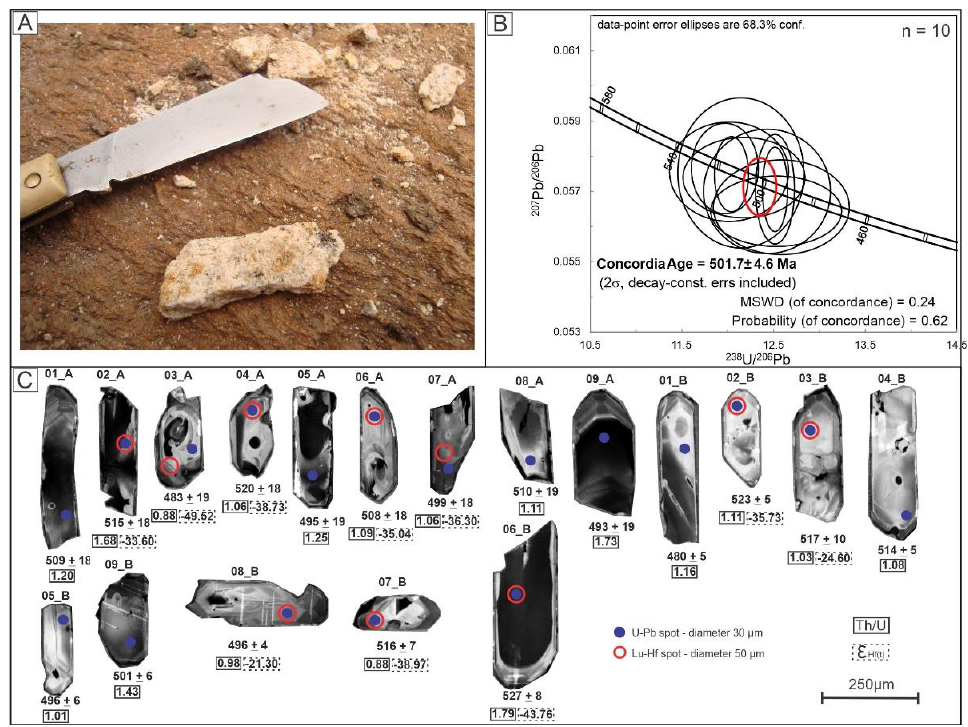
Figure 8. ( A ) A representative sample of SAIC granite type 1 from the point SAIC-12. ( B ) Concord age for the sample SAIC-12. ( C ) Cathodoluminescence image of the analyzed zircon